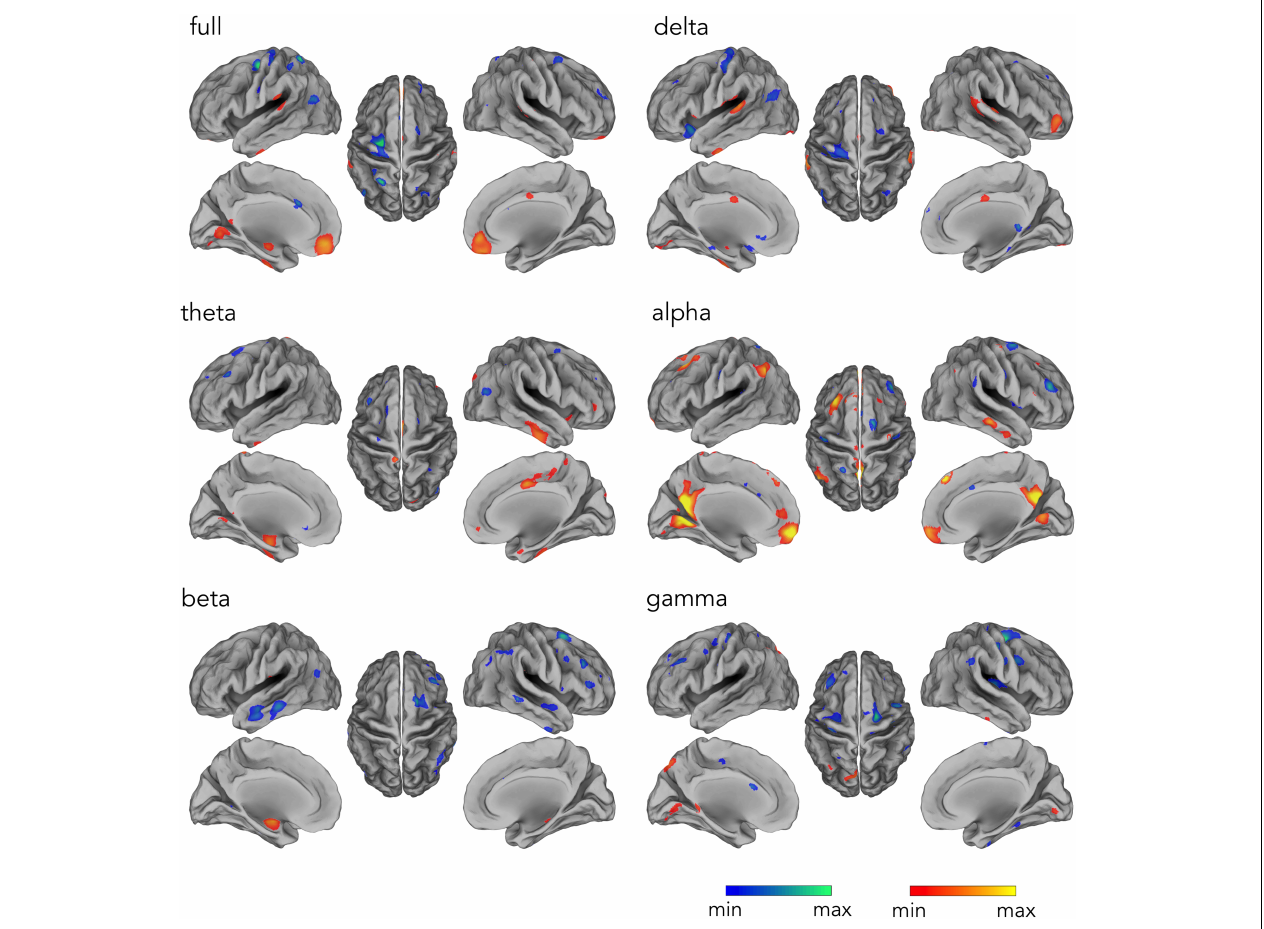
FIGURE 4 | Temporal profile of the hdEEG-derived DMN activity correlating with fMRI signals in delta (1–4 Hz), theta (4–8 Hz), alpha (8–13 Hz), beta (13–30 Hz), and gamma (30–80 Hz), and full (1–80 Hz) band. Group-level correlation maps between DMN time-course and voxel-by-voxel fMRI signals ( n = 20, significance level p < 0.05 BY-FDR corrected).